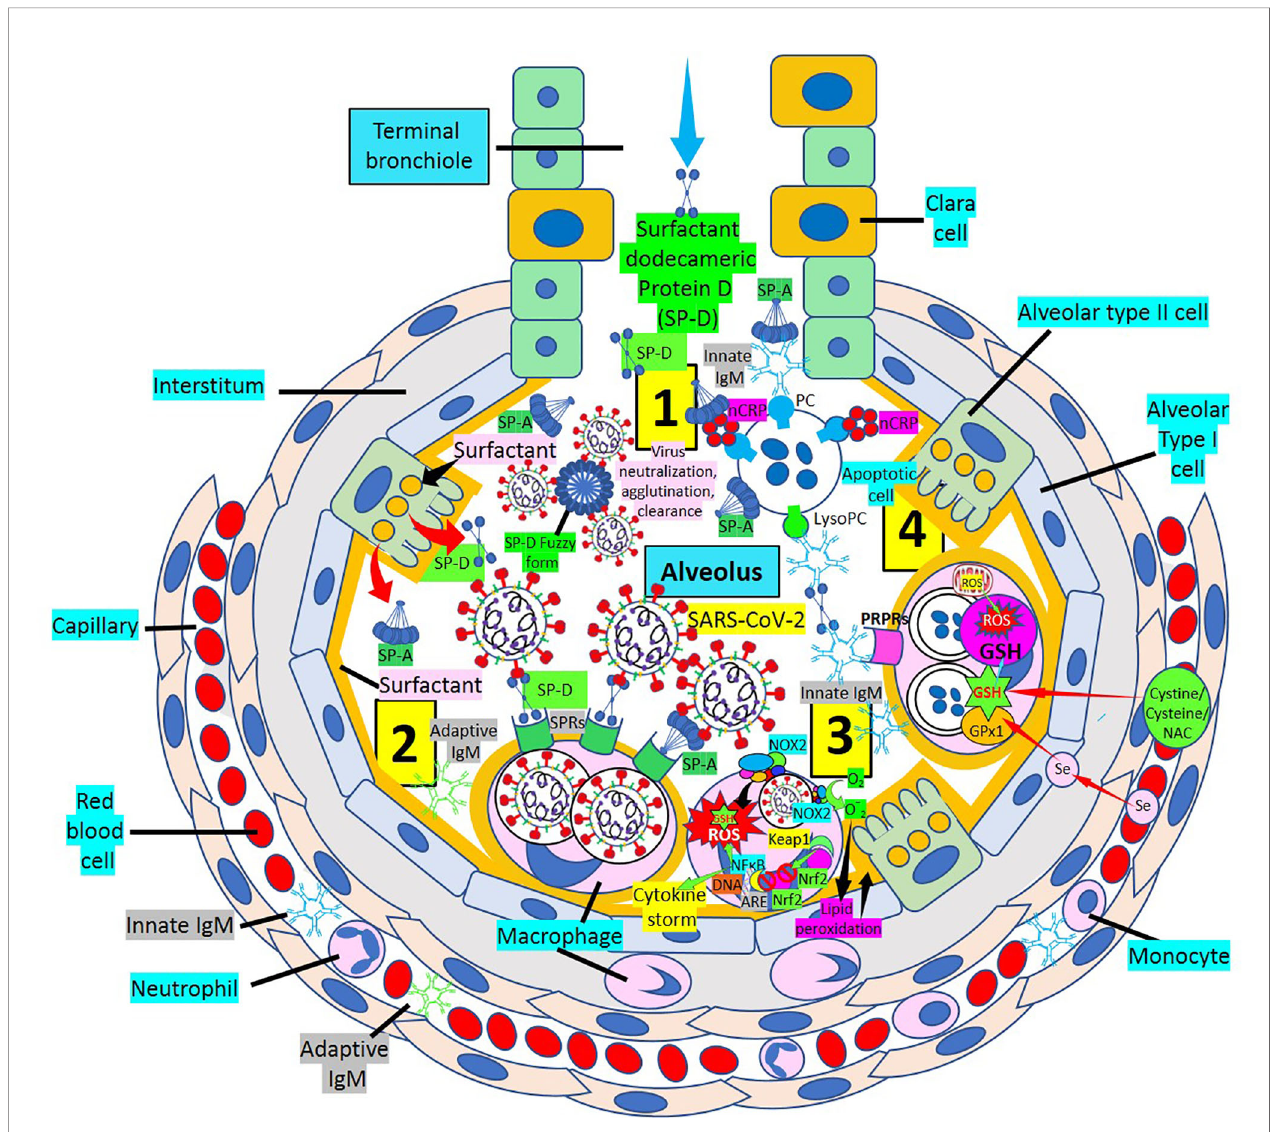
FIGURE 1 | Multiweapon approach to treat SARS-CoV-2 infection and COVID-19 disease. [1] Inhaled dodecameric surfactant protein D (SP-D) treatment in association with endogenous SP-D (dodecamers, fuzzy form) and urfactant protein A (SP-A) facilitate neutralization of SARS-CoV-2 particles. [2] SARS-CoV-2 particles can be phagocytosed by alveolar macrophages via surfactant protein receptors (SPRs). [3] Macrophage nicotinamide adenine dinucleotide phosphate (NADPH) oxidase (NOX2) generates superoxide ( O − 2 ) radicals increasing intracellular reactive oxygen species (ROS), causing lipid peroxidation and consuming GSH. Under oxidative stress and induced by ROS generation, nuclear factor erythroid 2 p45 – related factor 2 (Nrf2) is released from repression mediated by Kelch-like ECH-associated protein 1 (Keap1) and translocated to the nucleus where it binds antioxidant response element (ARE) to activate antioxidant enzymes. Excessive and continuous oxidative stress inhibits Nrf2 translocation into the nucleus and enhances nuclear factor-kB (NF- k B) activation promoting in fl ammation, oxidative damage, and cytokine storm. Supplementing selenium and GSH precursors [cystine, cysteine, N-acetyl cysteine (NAC)] enhances GSH peroxidase-1 (GPx1) and GSH levels, respectively, increasing GSH activity and ROS neutralization. [4] Pattern recognition proteins (PRPs) such as native pentameric C-reactive protein (nCRP) bound to phosphorylcholine (PC), innate IgM/SP-A, CRP/SP-A, and SP-A participate in the removal of apoptotic cells, in association with SP-D and innate/adaptive IgM molecules via pattern recognition protein receptors (PRPRs). lysoPC,